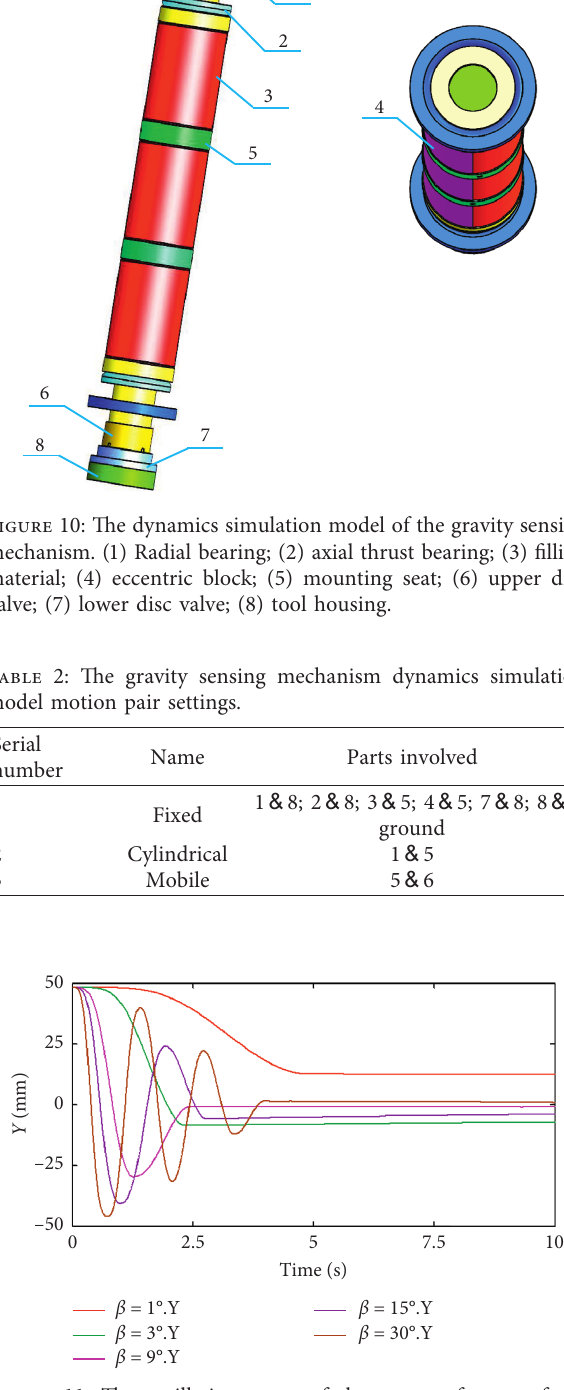
Figure 11: The oscillation curve of the center of mass of the platform in Y direction when F P � 100N and ϕ � ( π /2 ) under different well inclination angles β